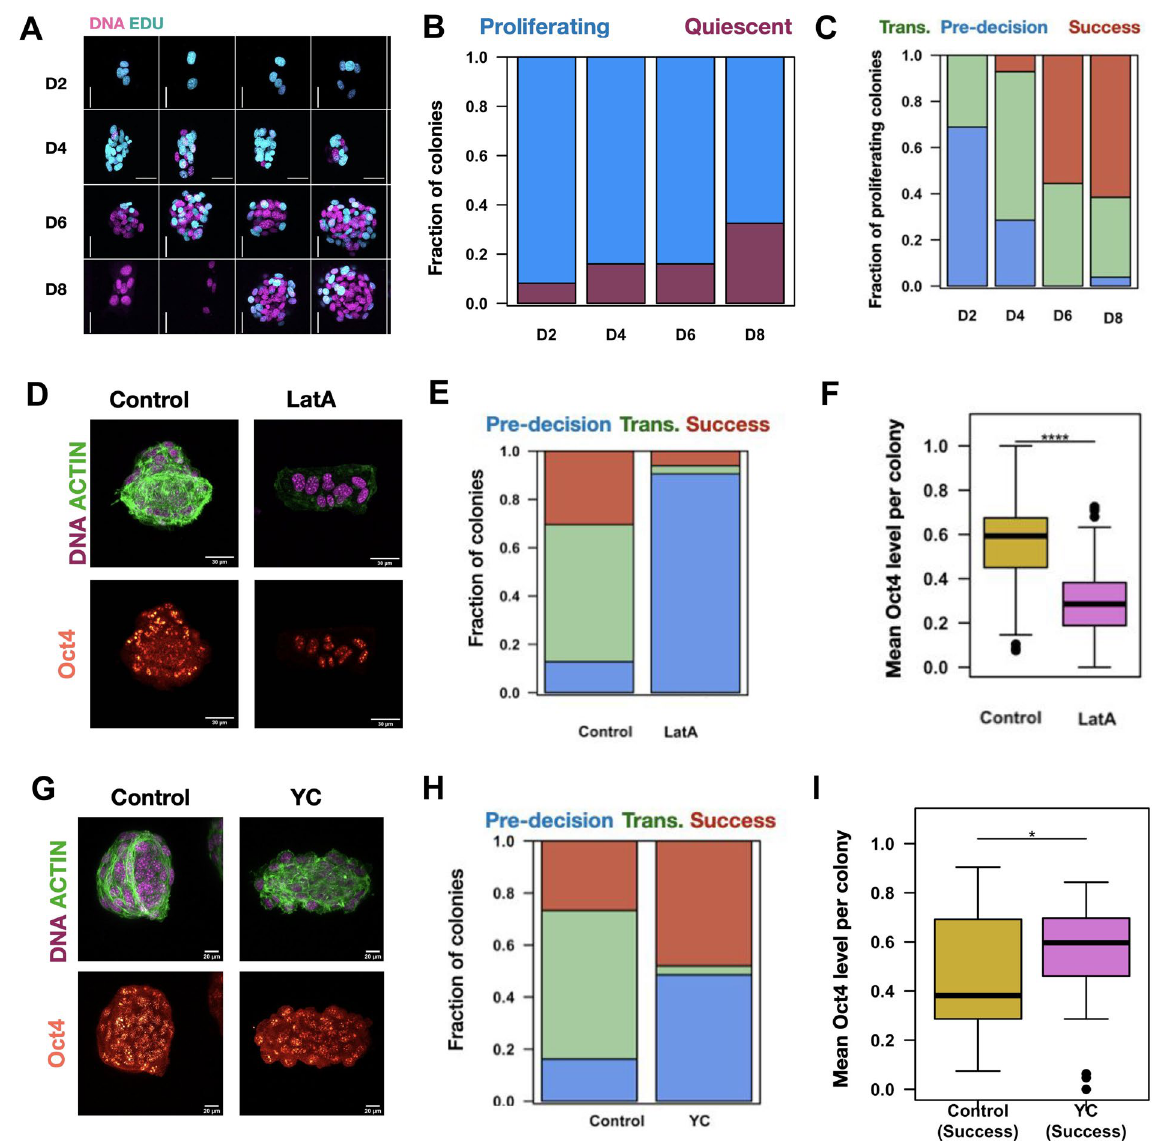
Figure 4. Acto-myosin contractility regulates the cellular decisions during laterally confined growth: ( A ) montages of Edu labeled colonies from day 2 to 8. Edu (Cyan) and DNA (Magenta). Scale bar = 20 microns. ( B ) Stacked barplot of the fraction of colonies that are Proliferating. Colonies with at least one Edu positive nucleus are identified to be Proliferating (blue) and the rest are labeled Quiescent (orchid). ( C ) The branch membership fraction of Proliferating colonies from day 0 to day 8. The color code is displayed along the top margin. ( D ) Representative images of control and Latrunculin A (LatA) treated colonies at day 10. F-Actin (Green), DNA (Magenta) and Oct4 (Heat Colors). Scale bar = 20 μm. ( E ) The branch membership fraction of colonies under the two culture conditions. The color code is displayed along the top margin. ( F ) Mean Oct4 Levels of control and Latrunculin A (LatA) treated colonies at day 10. n = 3 biological replicates, p < 0.0001. ( G ) Representative images of control and Y Compound (YC) treated colonies at day 10. F-Actin (Green), DNA (Magenta) and Oct4 (Heat Colors). Scale bar = 20 μm. ( H ) The branch membership fraction of colonies under the two culture conditions. The color code is displayed along the top margin. ( I ) Mean Oct4 Levels of control and Y-Compound (YC) treated colonies that belong to the success branch at day 10. p < 0.05 n = 3 biological that the majority of the colonies that are proliferating at day 8, belong to the success branch (Fig. 4C). Therefore, colonies that continue to proliferate after 6 days of laterally confined growth likely belong to the success branch. To check if this was true, we plotted the proliferation (Edu) status of the colonies after the branching point at day 4. In line with our hypothesis, we find that the colonies in the success branch continue to proliferate whereas those in the transient branch do not (Fig. S4D,E). Hence, we posit that the variable growth kinetics induced by proliferative pausing contributes to the heterogeneity observed in the colony structure over time.